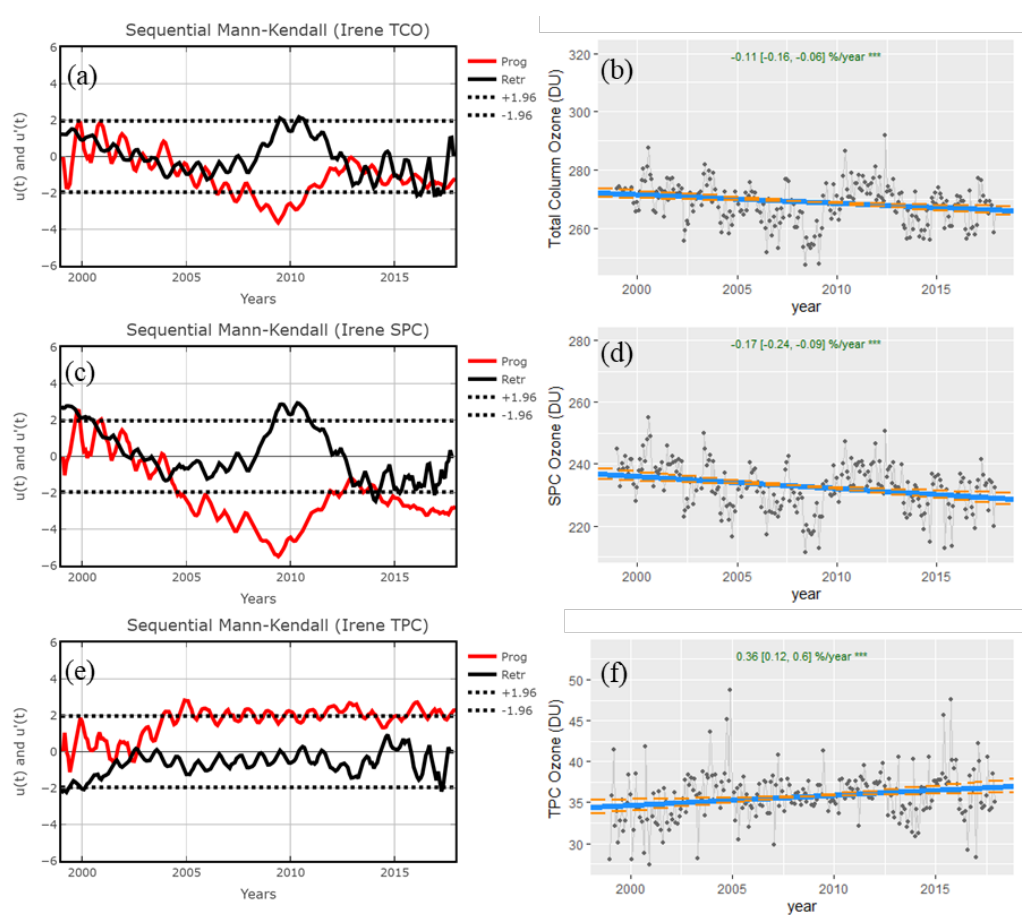
Figure 10. The inter-annual variation of (left panel) sequential statistics values of forward / progressive (Prog) u ( t ) (solid red line) and backwards / retrograde u ’( t ) (black solid line) obtained by the sequential Mann–Kendall (SQ-MK) test for TCO ( a ), SPC ( c ), and TPC ( e ). The right-hand side panel is the Theil–Sen plot for the TCO ( b ), SPC ( d ), and TPC ( f ) time